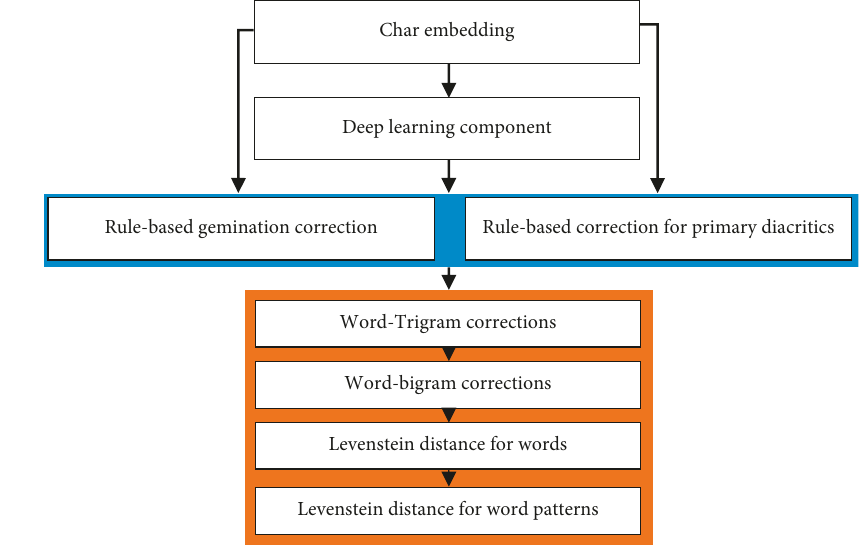
Figure 4: The architecture of the